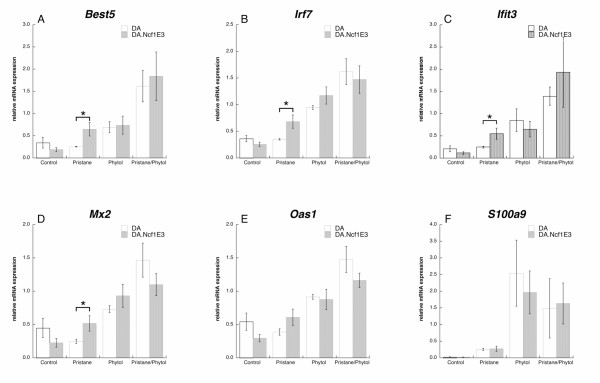
Gene-expression comparison between DA (open bars) and DA. Ncf1E3 (filled bars) of (A) Best5, (B) Irf7, (C) Ifit3, (D) Oas1, (E) Mx2 and (F) S100a9 in inguinal lymph nodes 10 days after injection. Values are means ± SEM of 4–5 animals per group. Levels of significance between the strains were calculated using Student's t-test (*p < 0.05).